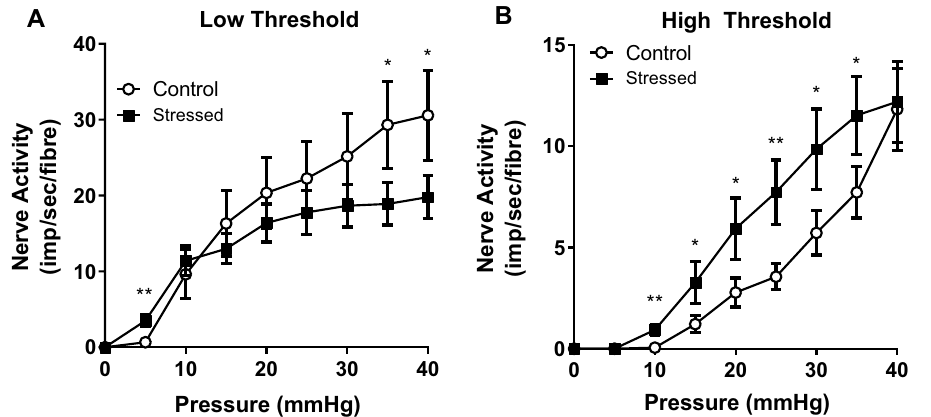
Figure 4. Nerve activity of low and high threshold fibres in control and stressed bladders during bladder filling to 40 mmHg intravesical pressure. Data represented as mean ± SEM (n ≥ 15) and analysed by un-paired Students t test (*p < 0.05 and **p < 0.01 control vs stressed